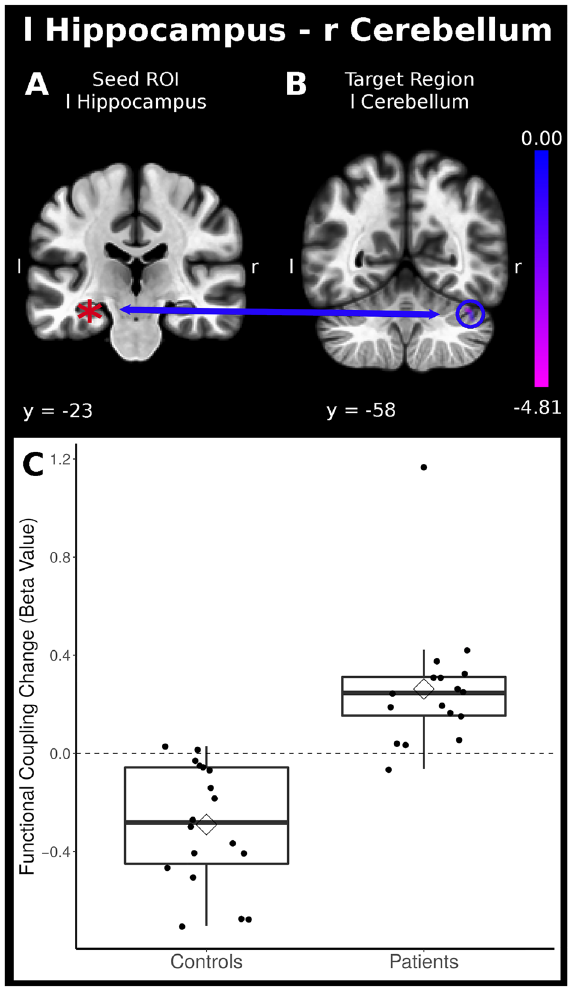
Figure 2. For the limbic and anterior parahippocampal network, increased task-related functional connectivity was disclosed between the seed hippocampal gyrus and the right cerebellum as a function of behavioral adaptation ( P < 0.05 FWE-corrected, the coordinates are displayed in Table 2). Below are the boxplots of the Beta Values for the patients and control